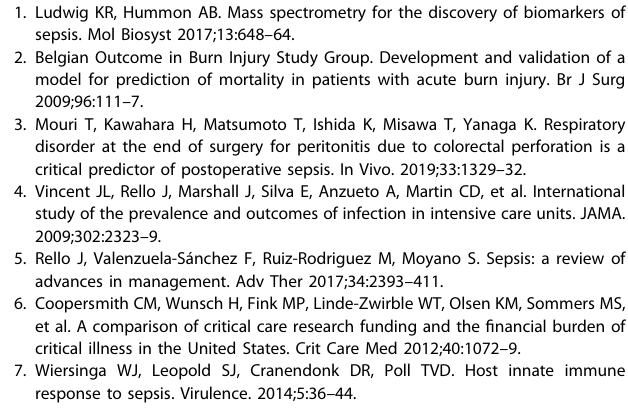
Fig. 7 Sesn2 inhibits the ATF4-CHOP-CHAC1 signaling pathway to protect DCs against LPS-induced ferroptosis. DCs were treated with Sal (20 mM/L) 1 h before LPS stimulation. Cells cultured for 24 h with only LPS were used as the control. A Expressions of ATF4, CHOP, and CHAC1, as detected by Western blotting, were increased under LPS stimulation. * P < 0.05 for the WT-LPS group vs. the control group; # P < 0.05 for the Sesn2 − / − -LPS group vs. the control group ; & P < 0.05 for the Sesn2 − / − -LPS group vs. the WT-LPS group. B Expressions of signaling pathway- related proteins including ATF4, CHOP, CHAC1 and the ferroptosis-related proteins xCT, GPX4, ACSL4, and TFRC in DCs pretreated with Sal before LPS stimulation, were determined by immunoblotting. C – E Levels of GSH, Fe 2 + , and ROS in DCs were measured by detection kits. F Percentages of costimulatory phenotypes expressed on DCs were detected by fl ow cytometry. G – J The release of IL-12, IL-6, IL-1 β , and TNF- α , re fl ecting the degree of DC maturity and secretion was measured by ELISA. K – L DCs were cocultured with CD4 + T cells incubated with Con A to further determine the levels of IFN- γ and the IFN- γ /IL-4 ratio by ELISA. M Flow cytometry results. Data were presented as the mean ± SD from three replicates ( n = 3 per group). Statistical signi fi cance: * P < 0.05, ** P < 0.01 for the WT-LPS + Sal group vs. the WT-L P S group; # P < 0.05, ## P < 0.01 for the Sesn2 − / − -LPS + Sal group vs. the Sesn2 − / − -LPS group; & P < 0.05, && P < 0.01 for the Sesn2 − / − -LPS + Sal group vs. the WT-LPS + Sal